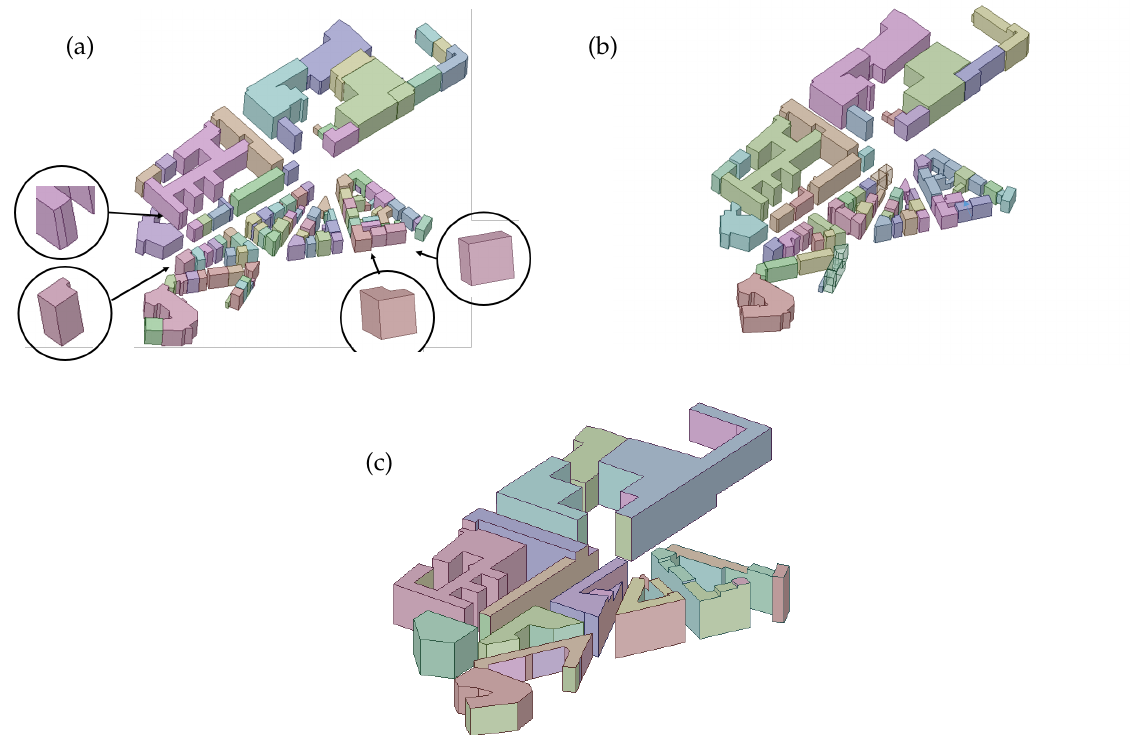
Figure 4. Buildings after various steps of the optimization: ( a ) using the sweep algorithm: many small details have been removed ( b ) additional optimization using Boolean operations: some buildings are automatically merged ( c ) final model after additional manual merging of buildings and removal of unnecessary details e.g., in the courtyards and partly closing of